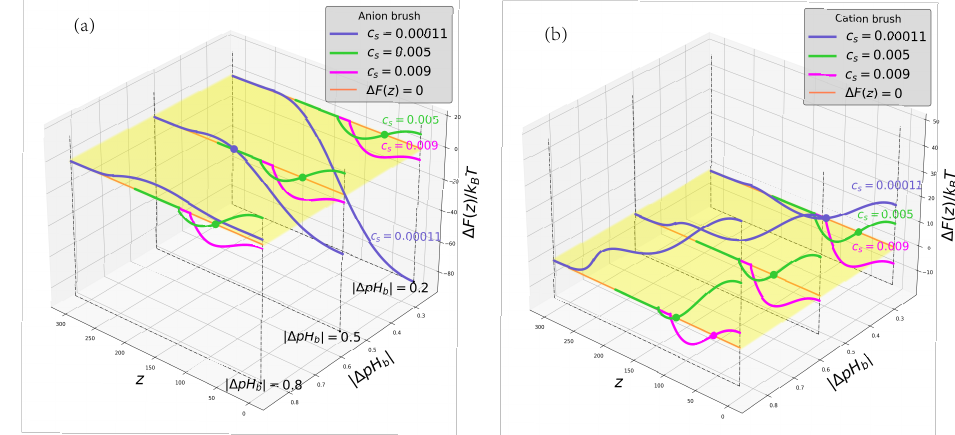
Figure 7. Cross-sections of the 2D profiles of the BSA insertion free energy ∆ F ( z , | ∆ pH b | ) , for the cases of polyanionic, pH b > pI ( a ) and polycationic, pH b < pI ( b ) brushes. The color code corresponding to different salt concentrations C s is indicated in the legend and at the curves. Colored circles correspond to the points of vanishing ∆ F ( z )